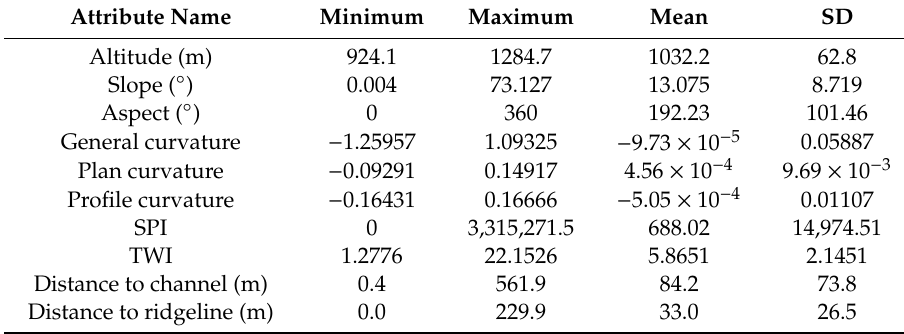
Statistics of topographic attributes. SPI—stream power index; TWI—topographic wetness